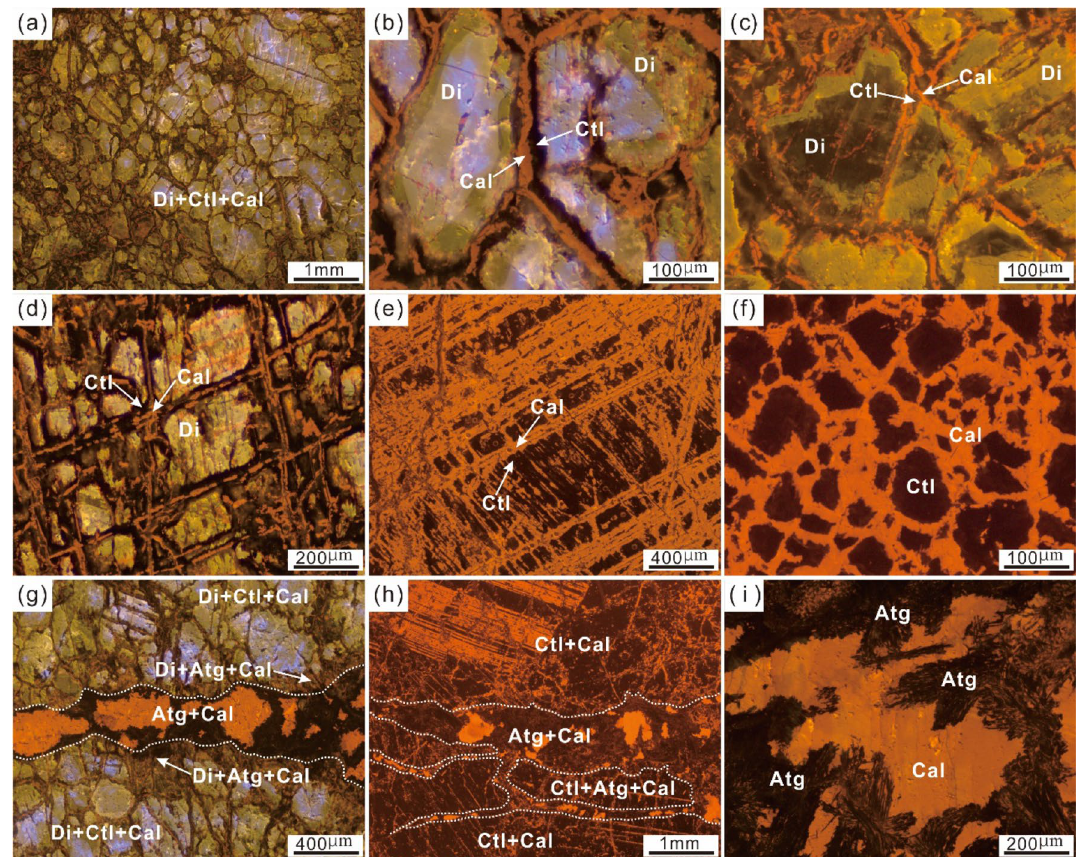
Figure 4. Optical cathodoluminescence (CL) images of serpentinized diopsidite from the Yushishan area. ( a ) Serpentinized diopsides with inhomogeneous cathodoluminescence. ( b ) Serpentinization occurred around a diopside grain (Di) and formed chrysotile (Ctl) + calcite (Cal). ( c ) Chrysotile and calcite formed along the cleavage plane of diopside. ( d ) Relict diopside rimmed by a layer of chrysotile followed by a layer of calcite. ( e ) Complete serpentinization of diopside forming along cleavages. ( f ) Complete serpentinization of diopside forming pseudomorphs of chrysotile + calcite with network fabrics. ( g ) Serpentinized diopsides crosscut by a late antigorite (Atg) + calcite vein. ( h ) Pseudomorph crosscut by a late antigorite + calcite vein with the chrysotile replaced by antigorite. ( i ) Late growth of antigorite and calcite